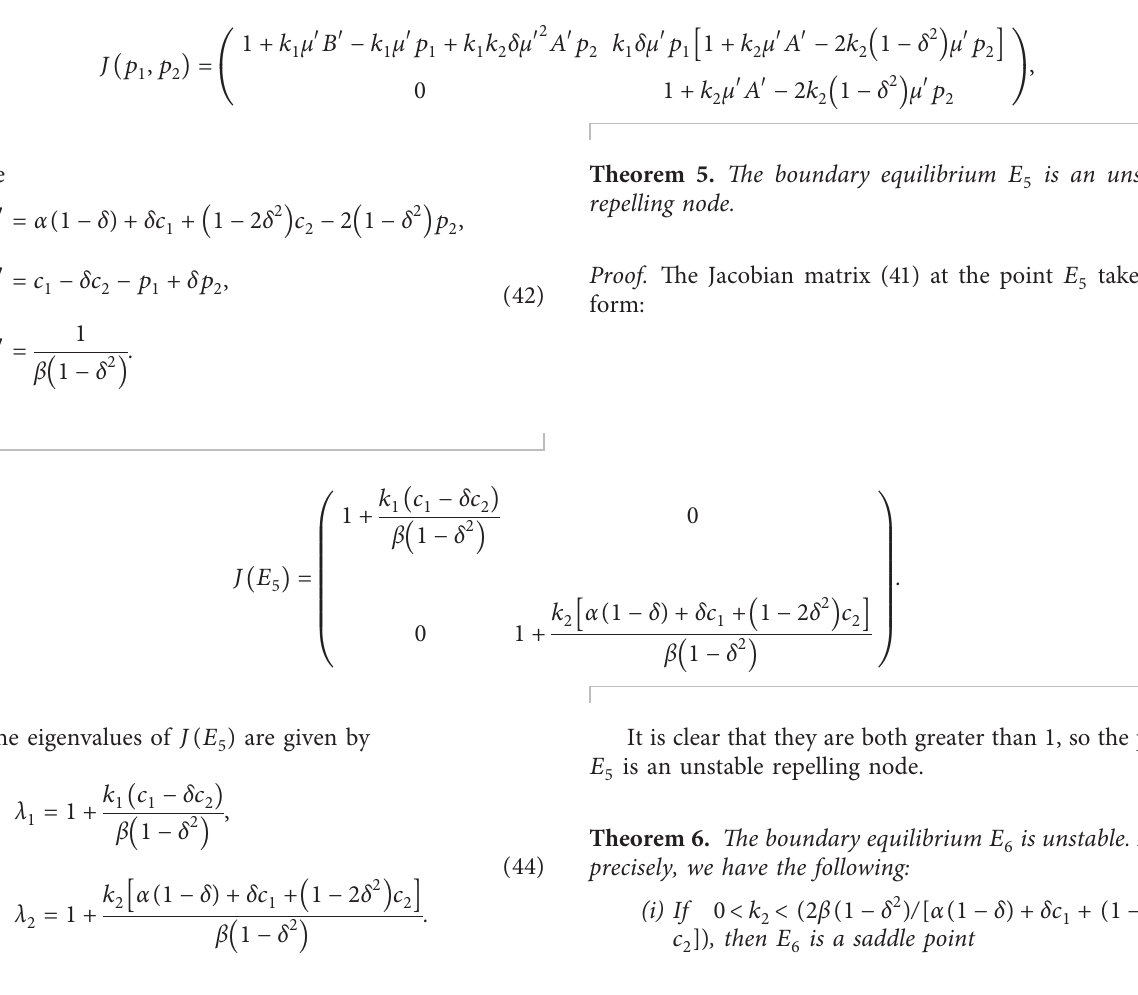
Figure 1: (a) The stability regions in the ( k regions in the ( k α � 0 . 7, β � 0 . 2, c